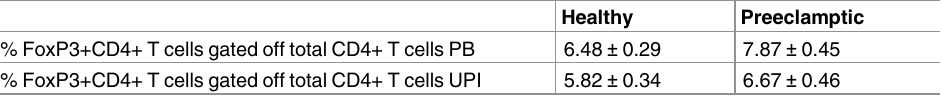
Table 9. Mean percentage +/- SEM FoxP3+CD4+ T cells gated off total CD4+ T cells in PB and at the UPI of healthy and preeclamptic (PE) patients, see also Fig 1B.